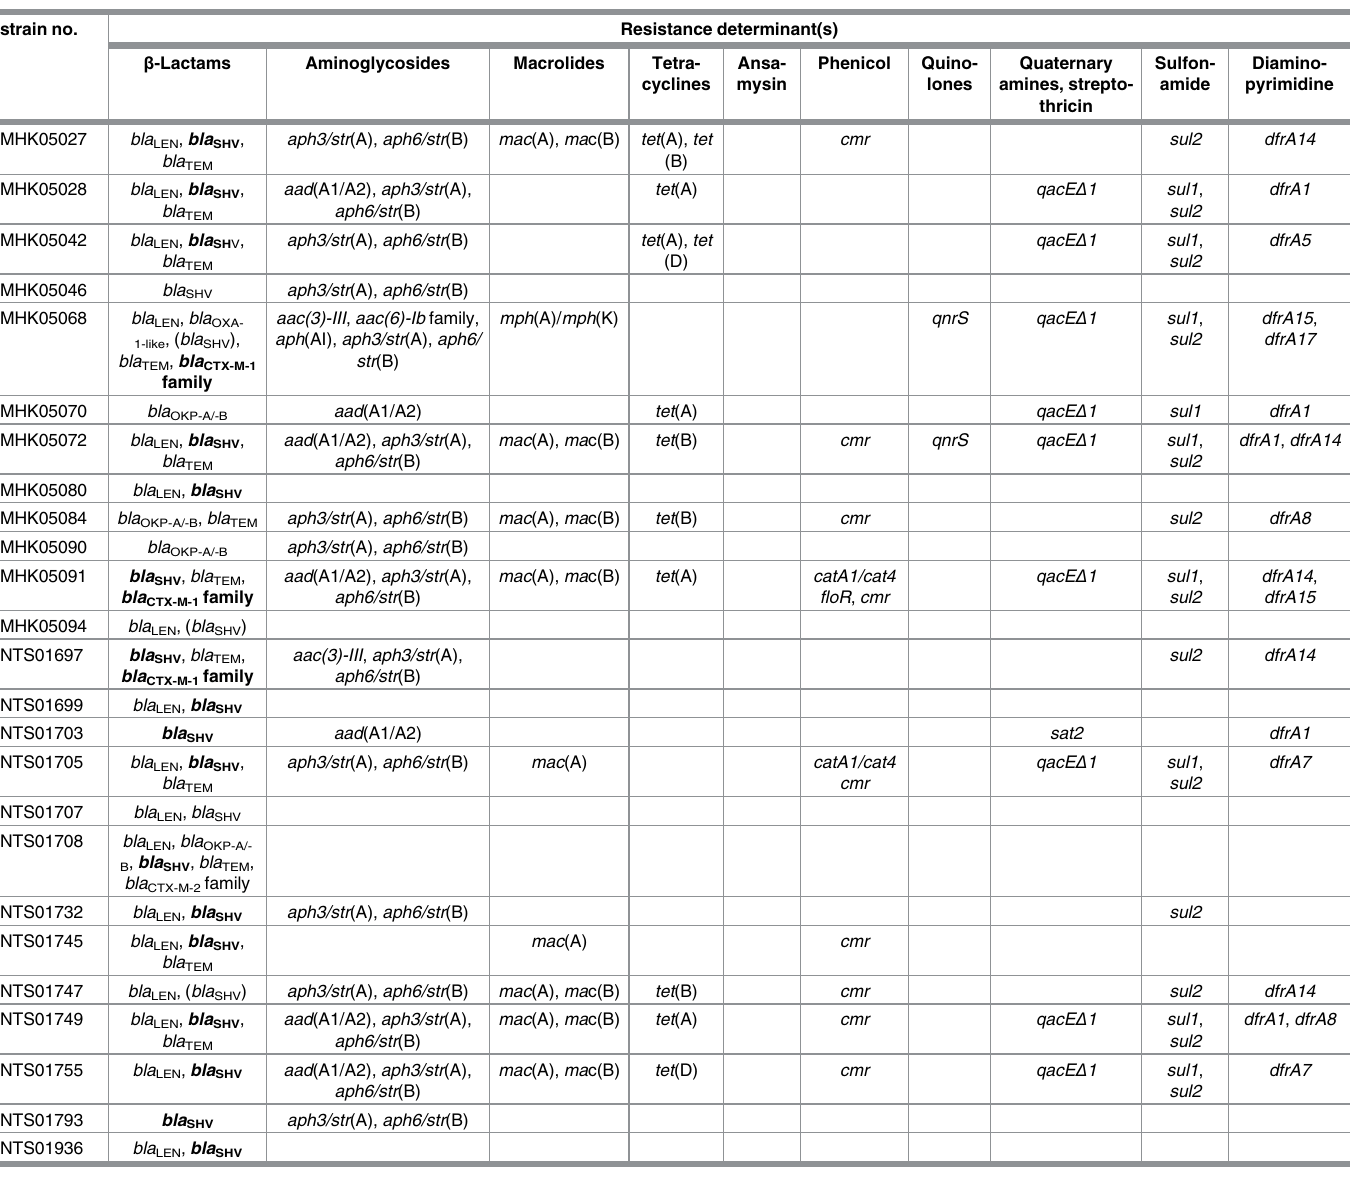
Almost half of the isolates were non-susceptible to tetracycline. Phenotypic resistance was positively correlated to the presence of a tetracycline resistance determinant ( P < 0.0005), although 10 isolates harboring resistance genes were phenotypically sensitive. Of the 38 tetra- cycline resistance genes on the ARDM v.2, only four were detected: tet (A) (18%), tet (D) (12%), tet (B) (10%), and tet (G)